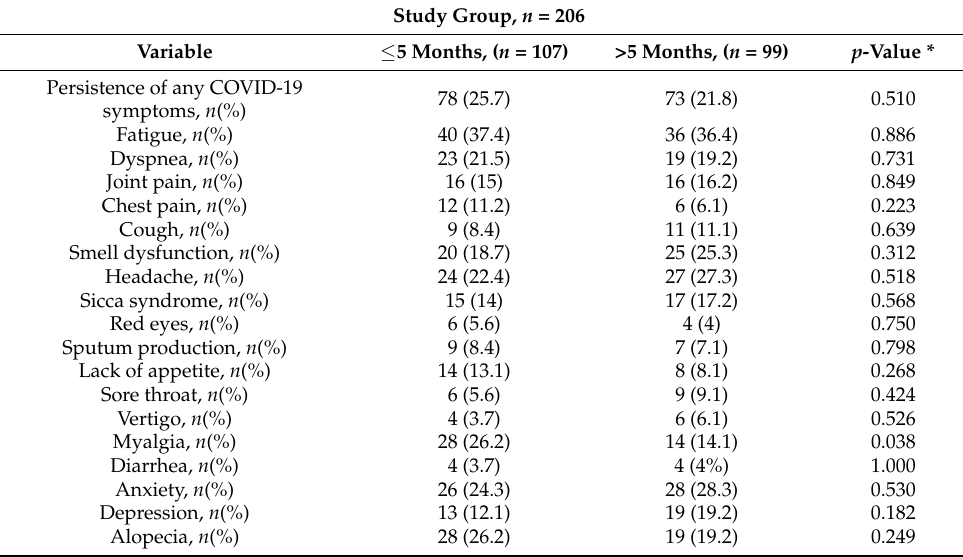
Table 4. COVID-19 persistent symptoms at different times after infection: a comparison be- tween groups.